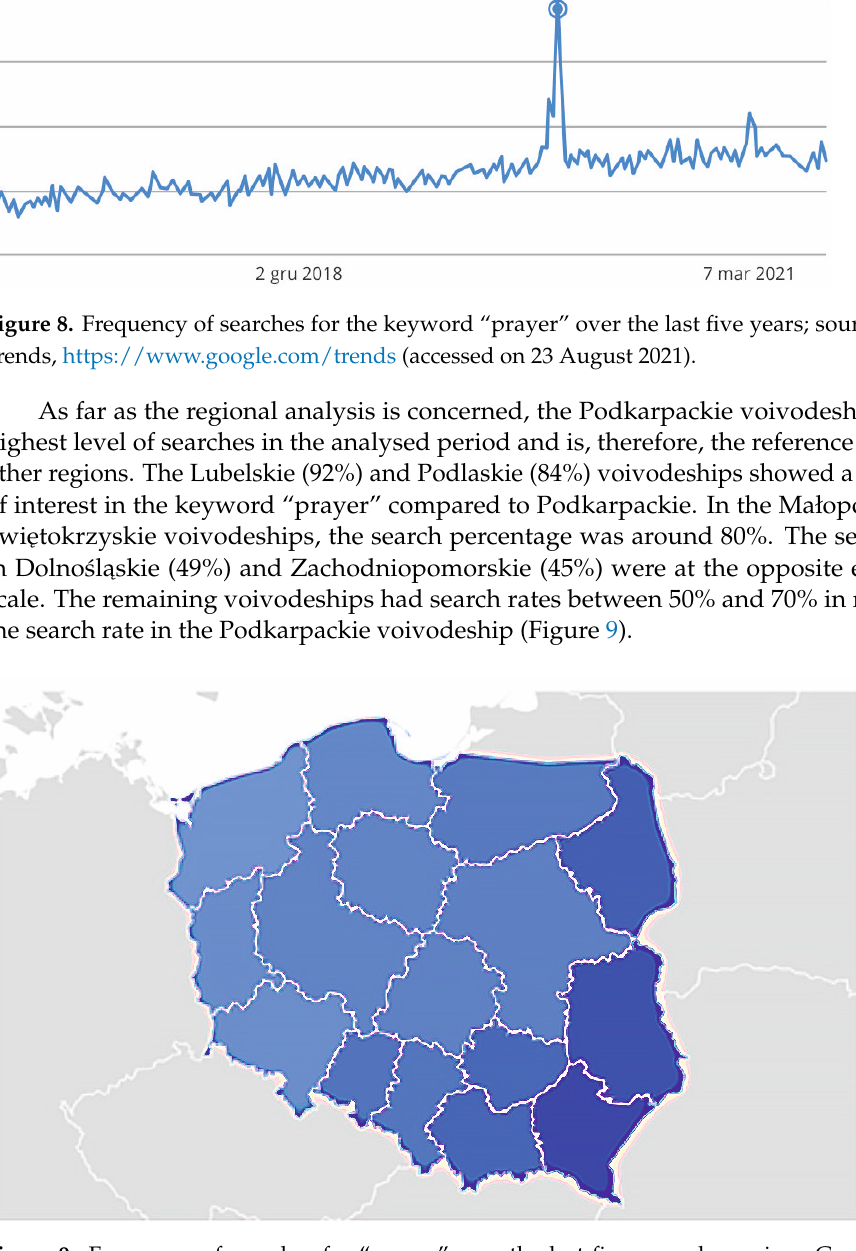
Figure 10. Frequency of searches for the keyword “confession” over the last five years; source: Google Trends, https://www.google.com/trends (accessed on 23 August 2021). The data show that in the weeks 18–24 December 2016, 9–15 April 2017, 17–23 De- cember 2017, 25–31 March 2018, 16–22 December 2018, 14–20 April 2019, and 15–21 De- cember 2019 there was a relative weekly average of queries above 50, normalised against the highest number of queries in the five-year period studied. For the other Christmas and Easter periods, increases in enquiries were at signifi- cantly lower levels. The number of enquiries during festive periods decreased more than twice between 2016–2019 and 2020–2021 (the pandemic period). As regards the regional analysis of the studied phenomenon, there were two regions with the highest number of searches for the keyword “confession” from August 2016 to August 2021. The data show that the greatest interest in the keyword was from the Pod- karpackie voivodeship, followed by the Ma ł opolskie voivodeship, with about 81% of the search interest in relation to the Podkarpackie voivodeship. The lowest interest in the search term in relation to the number of queries from the Podkarpackie voivodeship was